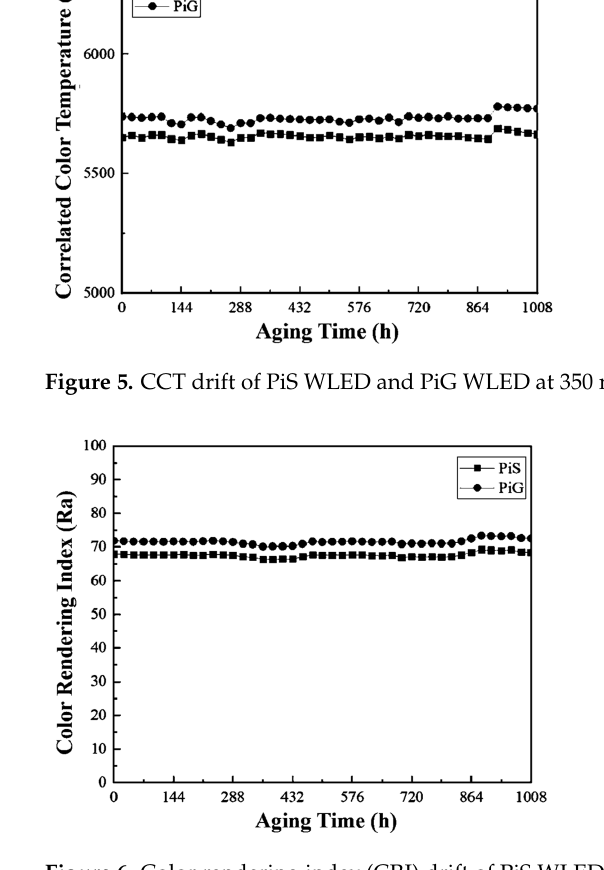
Figure 6. Color rendering index (CRI) drift of PiS WLED and PiG WLED at 350 mA for 1008 h. Table 3. Normalized light output flux, CCT, and CRI of PiS WLED and PiG WLED, and measured data before and after 350 mA lighting for 1008 h.